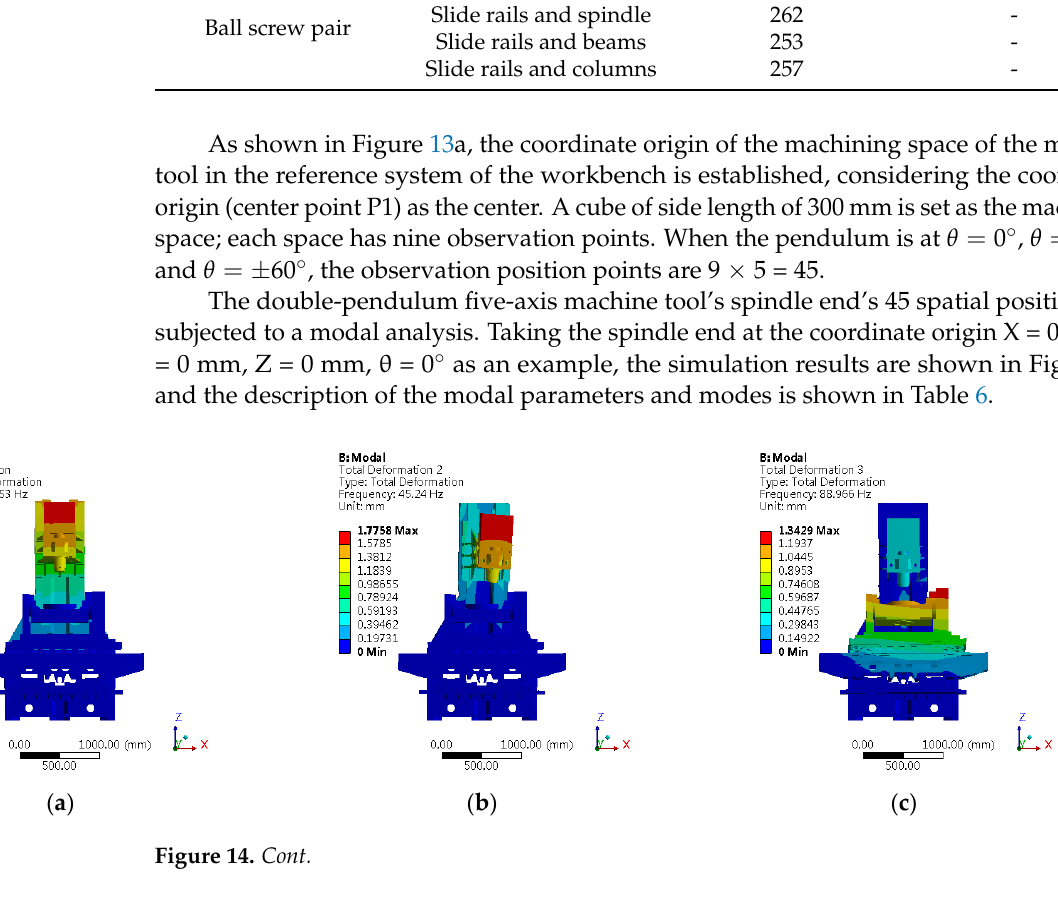
( f ) Figure 14. Modal results of the machine tool at the coordinate origin x = 0 mm, z = 0 mm, y = 0 mm, θ = 0°; ( a ) First mode; ( b ) Second mode; ( c ) Third mode; ( d ) Fourth mode; ( e ) Fifth mode; ( f ) Sixth mode. Table 6. First six-order natural frequencies of a two-axis rotary table five-axis machine tool. Mode Order